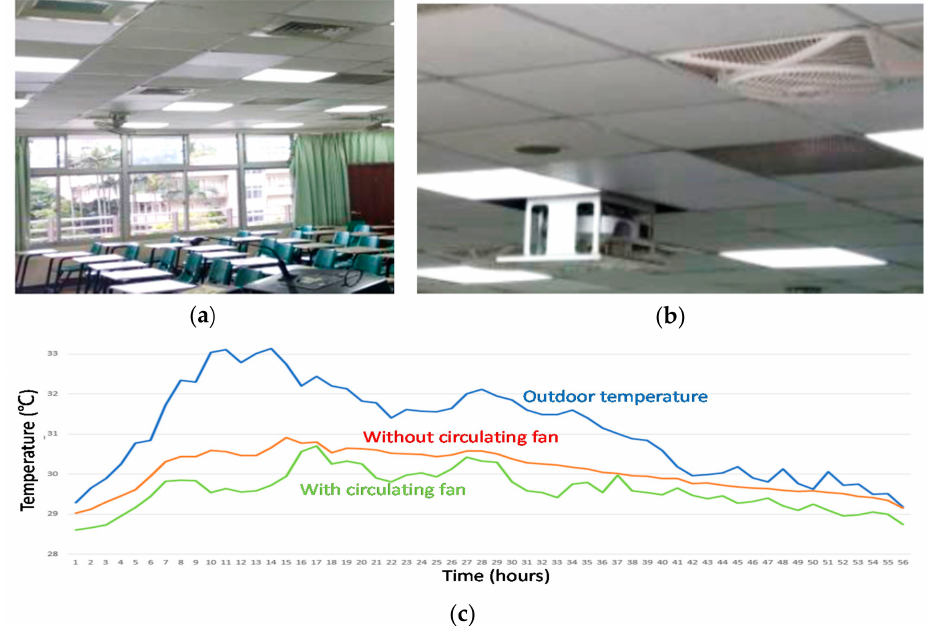
Figure 21. Circulating fans: ( a ) before improvement; ( b ) after improvement; ( c ) comparison of indoor and outdoor temperature